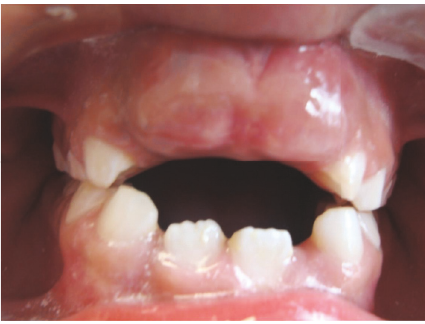
Figure 1: Initial frontal